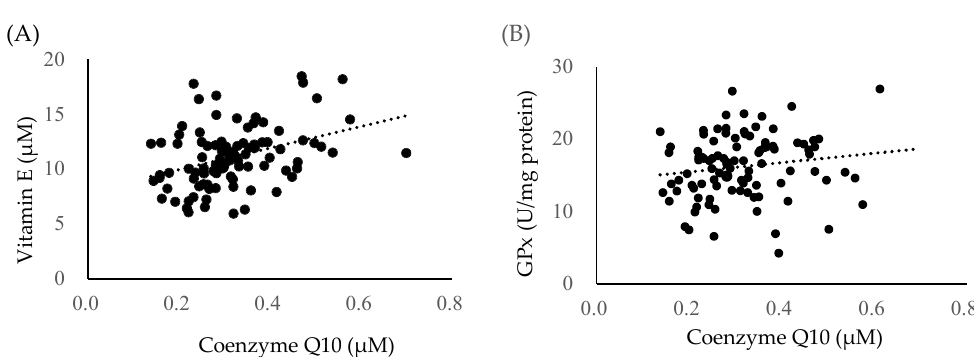
Figure 1. Correlations between the levels of coenzyme Q10 and vitamin E, and glutathione peroxidase activity (GPx) in HCC patients. ( A ) Correlation between the levels of coenzyme Q10 and vitamin E ( β = 9.85, p < 0.01); ( B ) Correlation between the levels of coenzyme Q10 and glutathione peroxidase (GPx, β = 6.43, p = 0.04).